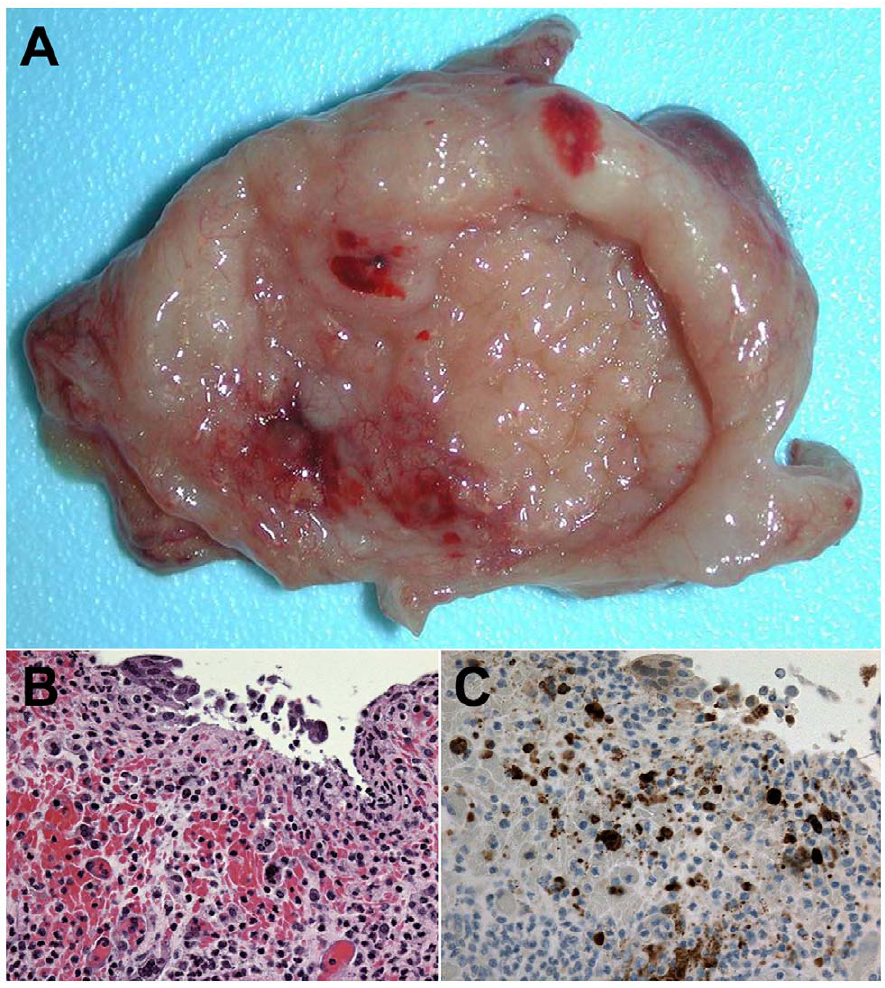
Figure 3. NiV infection and pathogenesis in the urinary bladder. Subject 3 that succumbed on day 11 after i.t. and oral exposure to 8.1 6 10 4 pfu of NiV. (A) Petechial to ecchymotic hemorrhages on mucosal surface of urinary bladder of animal of animal at necropsy. (B) Bladder ulcer showing inflammation and hemorrhage by H&E staining; 400 6 magnification. (C) Bladder ulcer by immunohistochemistry staining of NiV antigen; 400 6 magnification.